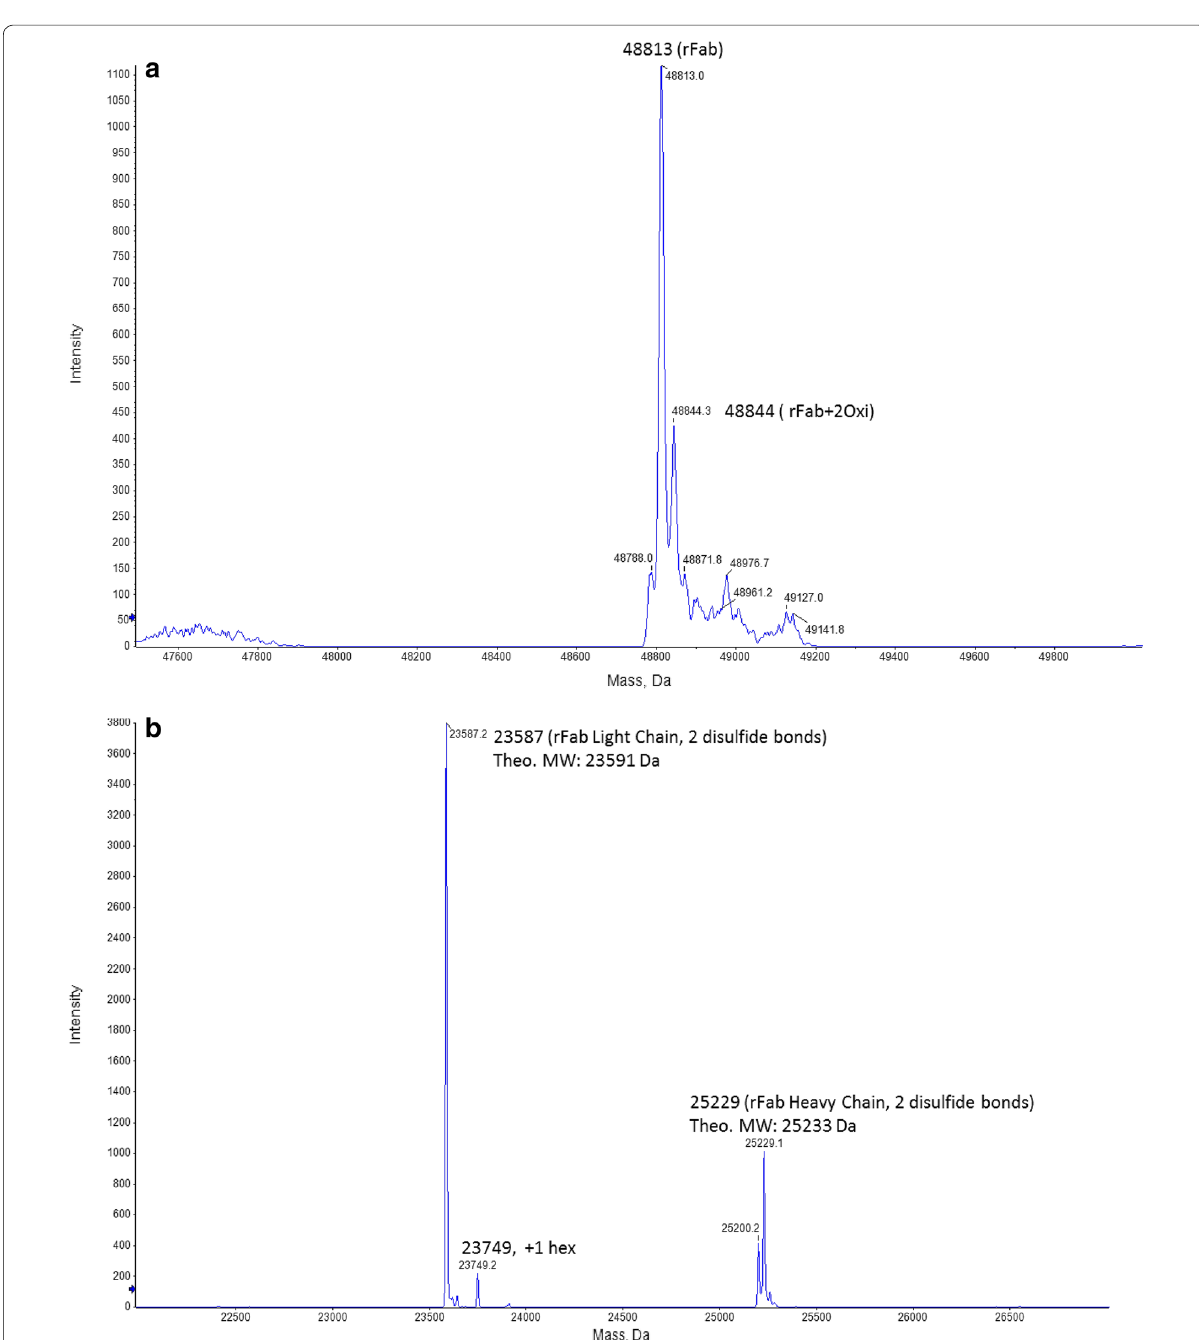
Fig. 5 a ESI–MS spectrum of rFab from bioreactor 1 under non-reduced condition. The MW profile of rFab was observed at 48,813 Da, and the MW profile of oxidized rFab with two oxidations was detected at 48,844 Da with 37% peak intensity percentage (Table 2). b ESI–MS spectrum of rFab from bioreactor 1 under TCEP-reduced condition. The MW at 23,587 Da matched with the light-chain theoretical MW with two disulfide bonds, and the MW at 25,229 Da matched with the heavy chain theoretical MW with two disulfide bonds. c ESI–MS spectrum of rFab from bioreactor 4 under non-reduced condition. The MW profile of rFab was observed at 48,813 Da, and no oxidized rFab was detected from bioreactor 4. d ESI–MS spectrum of rFab from bioreactor 4 under TCEP-reduced condition. The MW at 23,587 Da matched with the light-chain theoretical MW with two disulfide bonds, and the MW at 25,229 Da matched with the heavy chain theoretical MW with two disulfide bonds. e ESI–MS spectrum of rFab from bioreactor 8 under non-reduced condition. The MW profile of rFab was observed at 48,813 Da, and no oxidized rFab was detected from bioreactor 8. f ESI–MS spectrum of rFab from bioreactor 8 under TCEP-reduced condition. The MW at 23,587 Da matched with the light-chain theoretical MW with two disulfide bonds, and the MW at 25,229 Da matched with the heavy chain theoretical MW with two disulfide